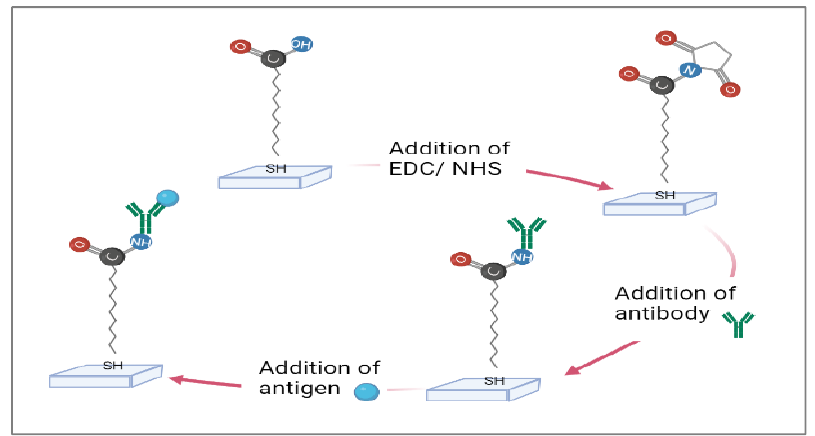
Figure 2. The graphic depicts the synthesis of SAM from 11-MUA on a gold electrode in combination with antibody immobilization. (Note abbreviations were included in Appendix A). with antibody immobilization. (Note abbreviations were included in Appendix